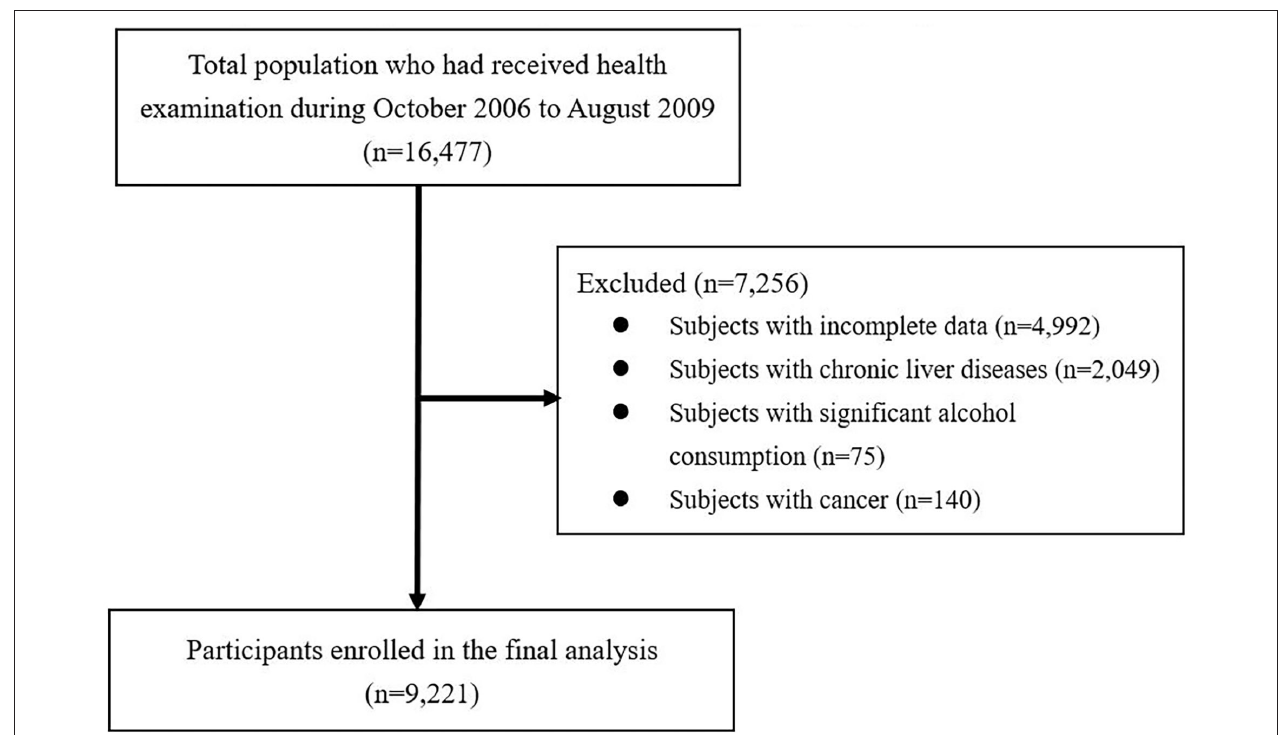
FIGURE 1 | Flow diagram showing the exclusion process for selecting eligible